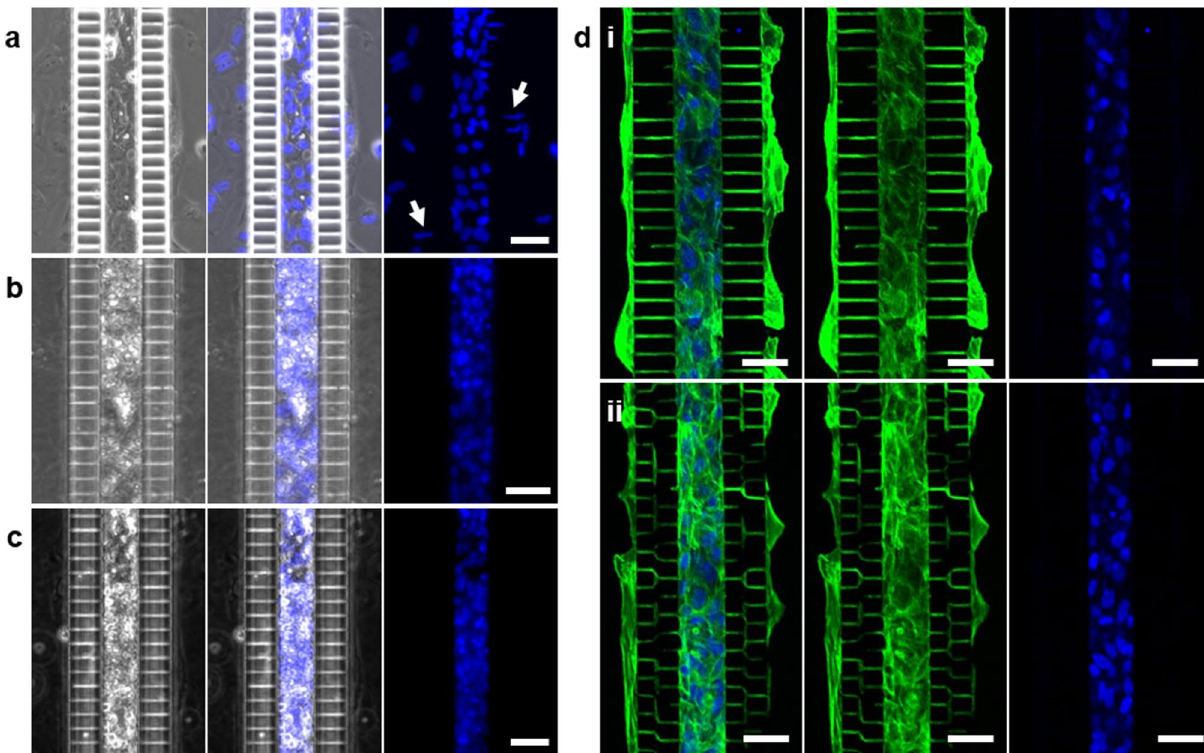
Figure 2. Evidence for the migration of proliferative HepaRG cells out of culture chambers determined by phase contrast imaging and fluorescent staining (blue: DAPI, green: phalloidin, staining cell nuclei and F-actin, respectively). Proliferative HepaRG cells loaded and observed after 2 days under static conditions, in different devices: ( a ) on a 25–5 µm device, the migration of cell nuclei through the slits was observed (white arrows); ( b ) on a 25–2 µm device; ( c ) on a 40–2 µm device. ( d ) Confocal microscope images of a chamber on the 40–2 µm device in the same conditions: (i) with straight slits or (ii) with discontinuous slits. Scale bars = 40